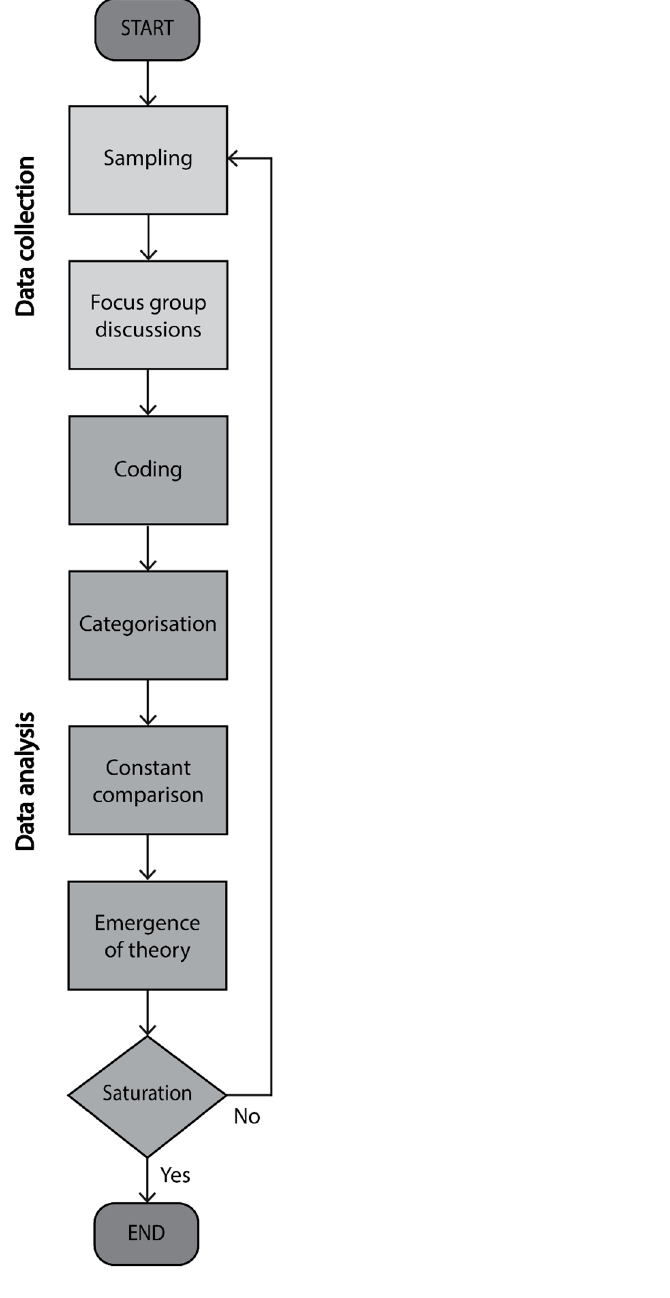
Figure 1. The main steps of data collection and analysis (based on a grounded theory approach) which were implemented in this study.